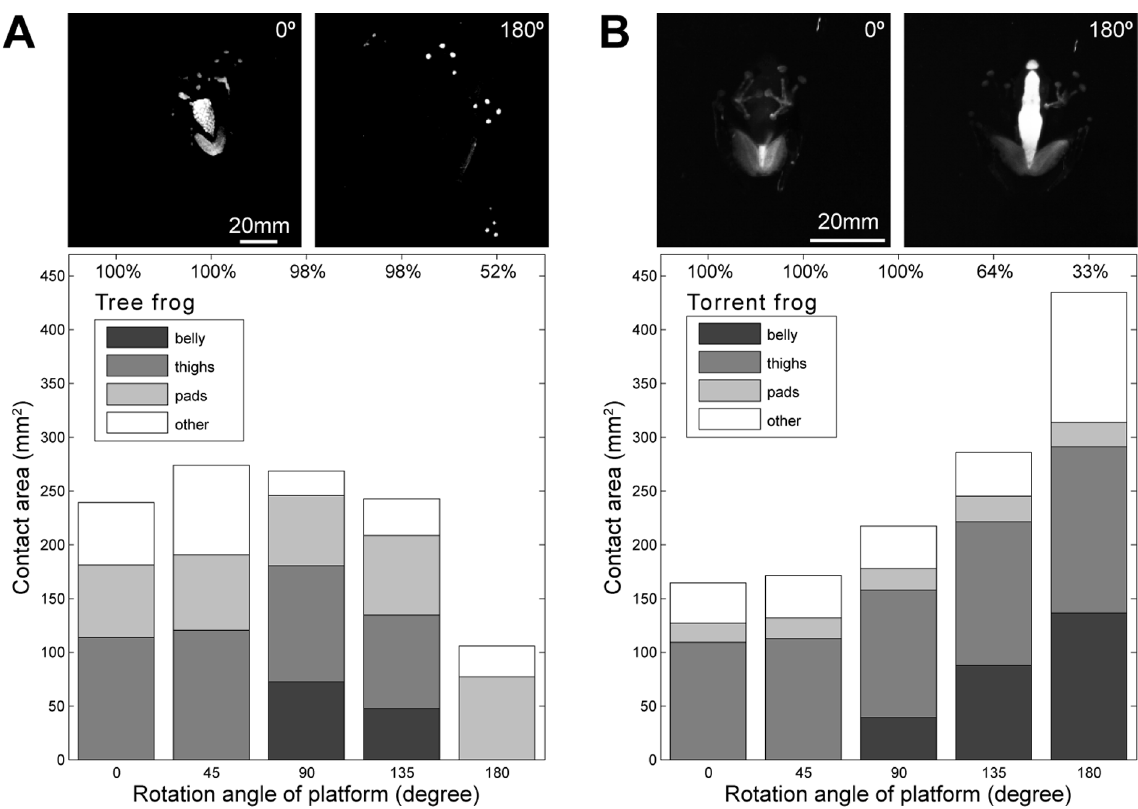
Figure 4. Contact areas of the two frog species at 5 tilting positions. Using a special illumination technique (see Materials and Methods), the contact area of ventral body parts (toe pads, belly, thighs and uncategorised areas) of (A) the tree frog ( R. pardalis ) and (B) the torrent frog ( S. guttatus ) was measured at 0 u , 45 u , 90 u , 135 u and 180 u . The photos at the top are images of the frogs at horizontal (0 u ) and inverted (180 u ) tilting positions. The plots represent medians of 42 trials from 6 frogs (tree frogs) and 33 trials from 6 frogs (torrent frogs), the percentages at the top representing the proportion of frogs still attached at each tilt angle.).